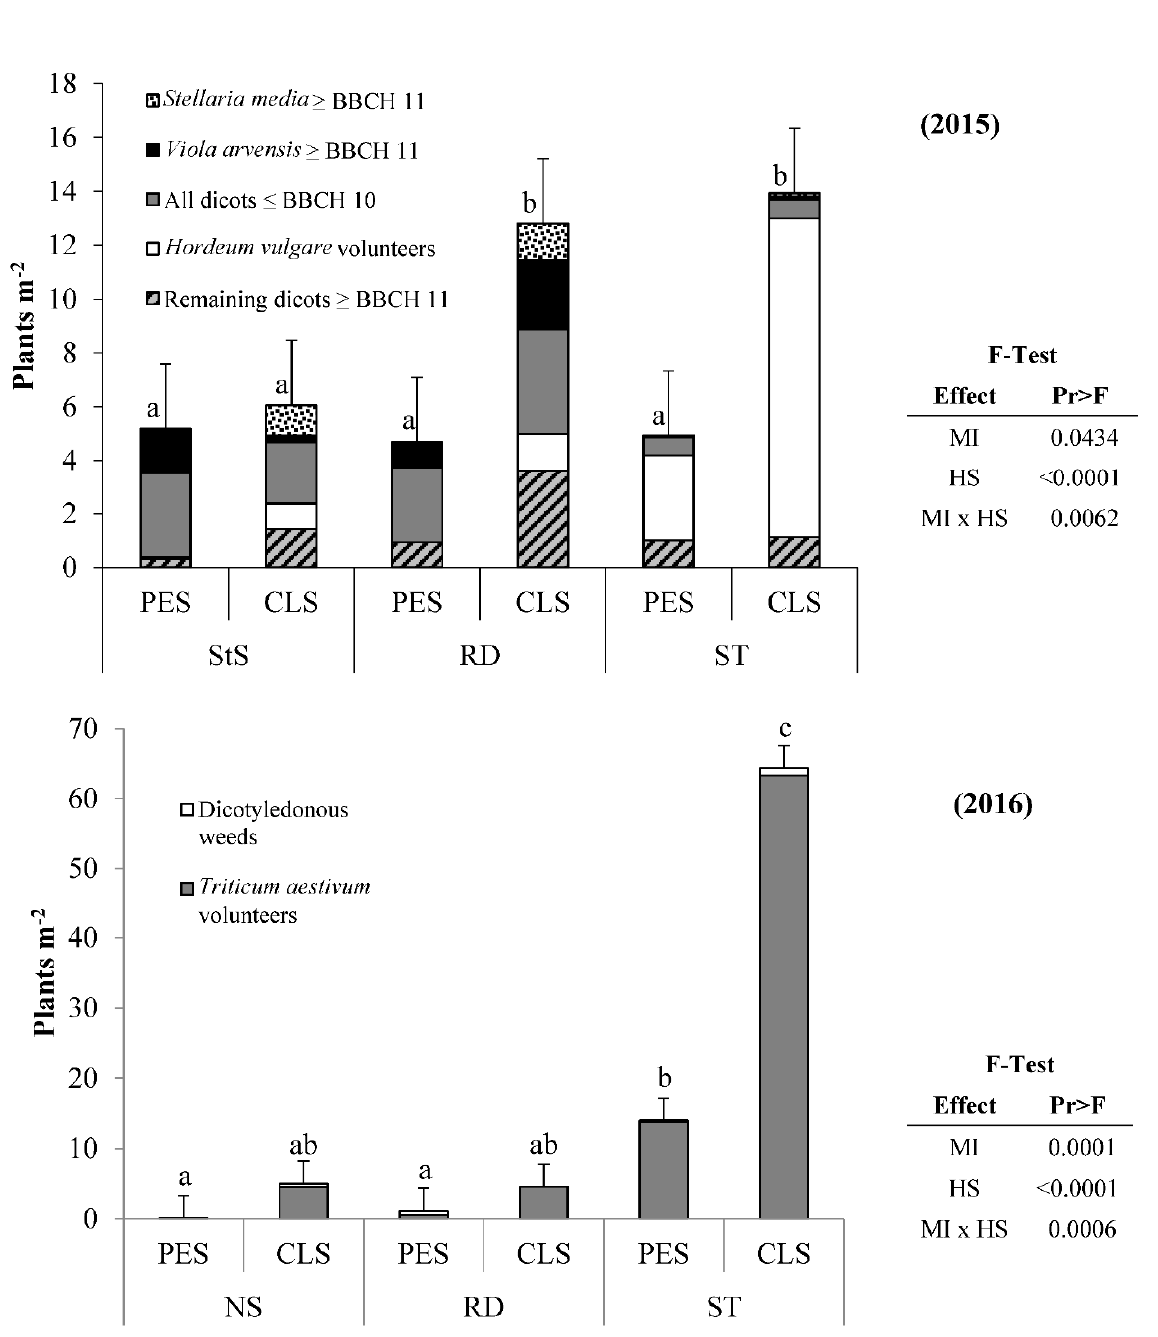
Figure 2. Weed density and weed composition in plants m − 2 in Clearfield ® -oilseed rape as effect of different management intensities and herbicide strategies in the years 2015 and 2016, experimental station Ihinger Hof. StS: standard sowing (mouldboard ploughing, 50 seeds m − 2 , 12 cm row spacing); RD: reduced sowing density (mouldboard ploughing, 25 sown seeds m − 2 , 50 cm row spacing); ST: strip-till (strip tillage, 25 seeds m − 2 , 50 cm row spacing); PES: pre-emergence application of Colzor ® Trio and post-emergence application of Agil ® -S. CLS: post-emergence application of Clearfield ® -Vantiga ® -D. Values labelled by the same letter are not significantly different; letters refer to the total number of weeds per variant ( α = 0.05; Student’s t -test). Error bars: standard error of mean. Experimental station: Ihinger Hof.